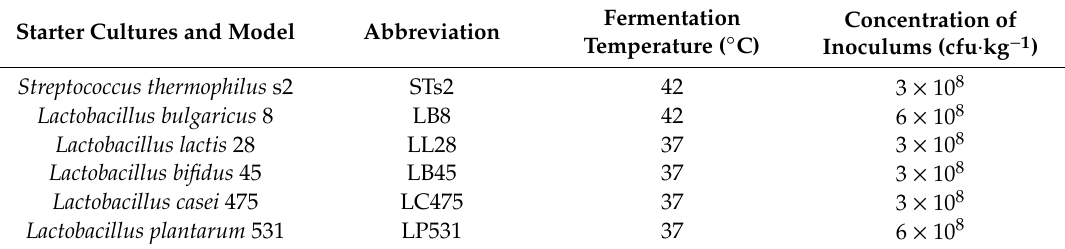
Table 3. Fermentation parameters of di ff erent starter